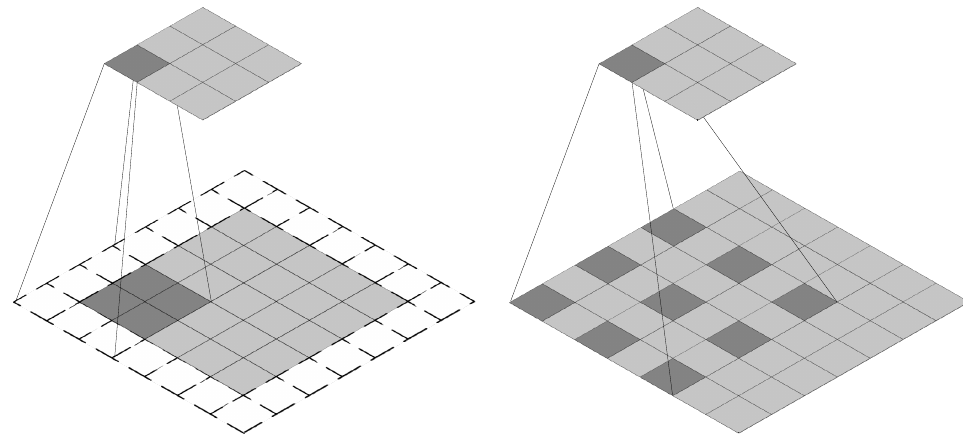
Figure 2. Comparison of ordinary convolution ( left ) and dilated convolution ( right ). After the newly added sixth and seventh convolutional layers, three more convolu- tional layers (conv8, conv9, and conv10) are added, and a layer is added to the network at the end to convert the output feature map of the previous layer into a